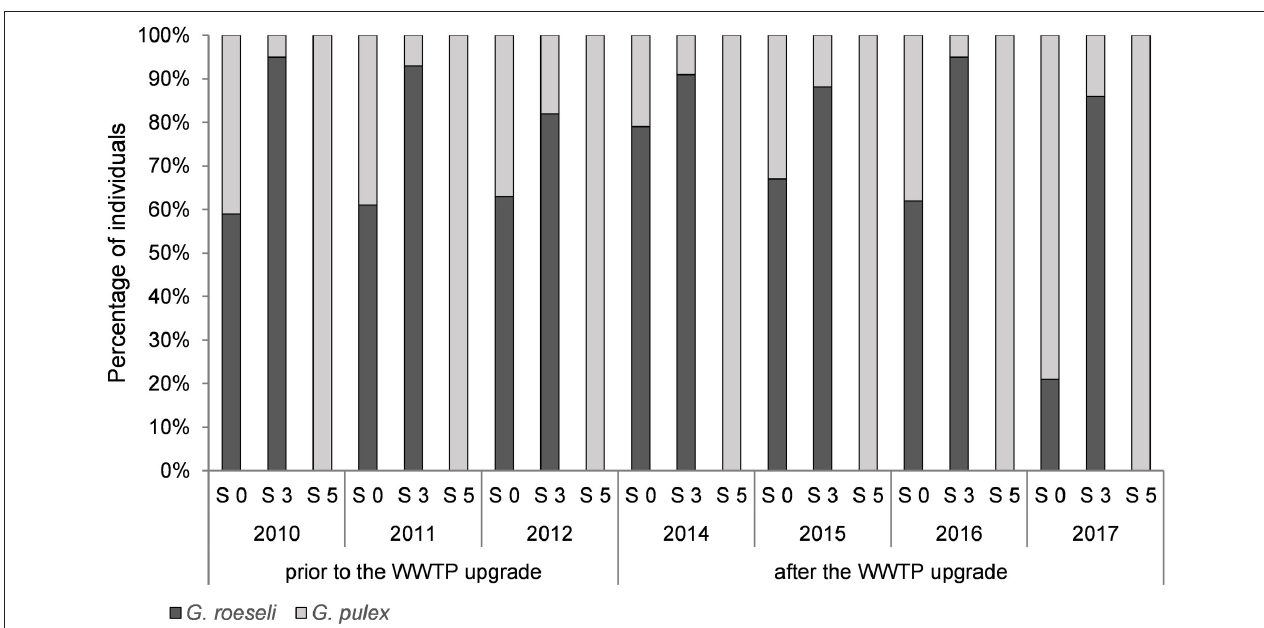
FIGURE 2 | Distribution of gammarid species prior to (2010–2012) and after (2014–2017) the wastewater treatment plant (WWTP) upgrade. Sampling sites at the Schussen river: S 0 upstream of the WWTP, S 3 downstream of the WWTP. Sampling site S 5 at the river Argen. Number of individuals at each sampling site is totalized for every year under investigation. Sample sizes in 2010, 2011, 2012, and 2014 at every sampling site: 300. Sample sizes in 2015: 200 at each sampling site. Sample sizes in 2016 and 2017 at each sampling site: 100. Statistically analyzed: Fisher’s exact test following sequential Bonferroni correction. Significant